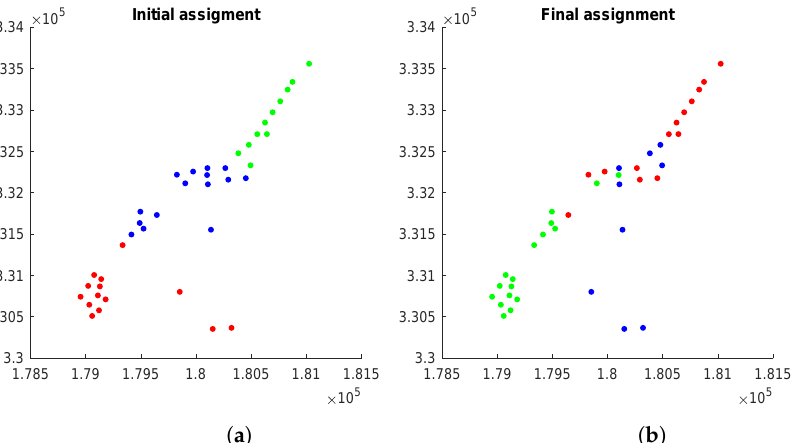
Figure 7. Sensing location assignments. We use three colors to differentiate assignments to the m = 3 robots. ( a ) Initial sensing location assignment; ( b ) Final sensing location assignment.